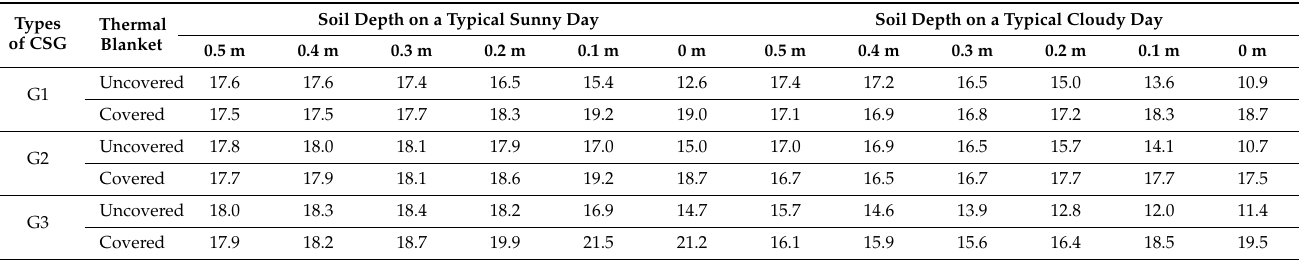
Table 1. Thickness of heat storage layer of soil in each greenhouse determined by temperature difference